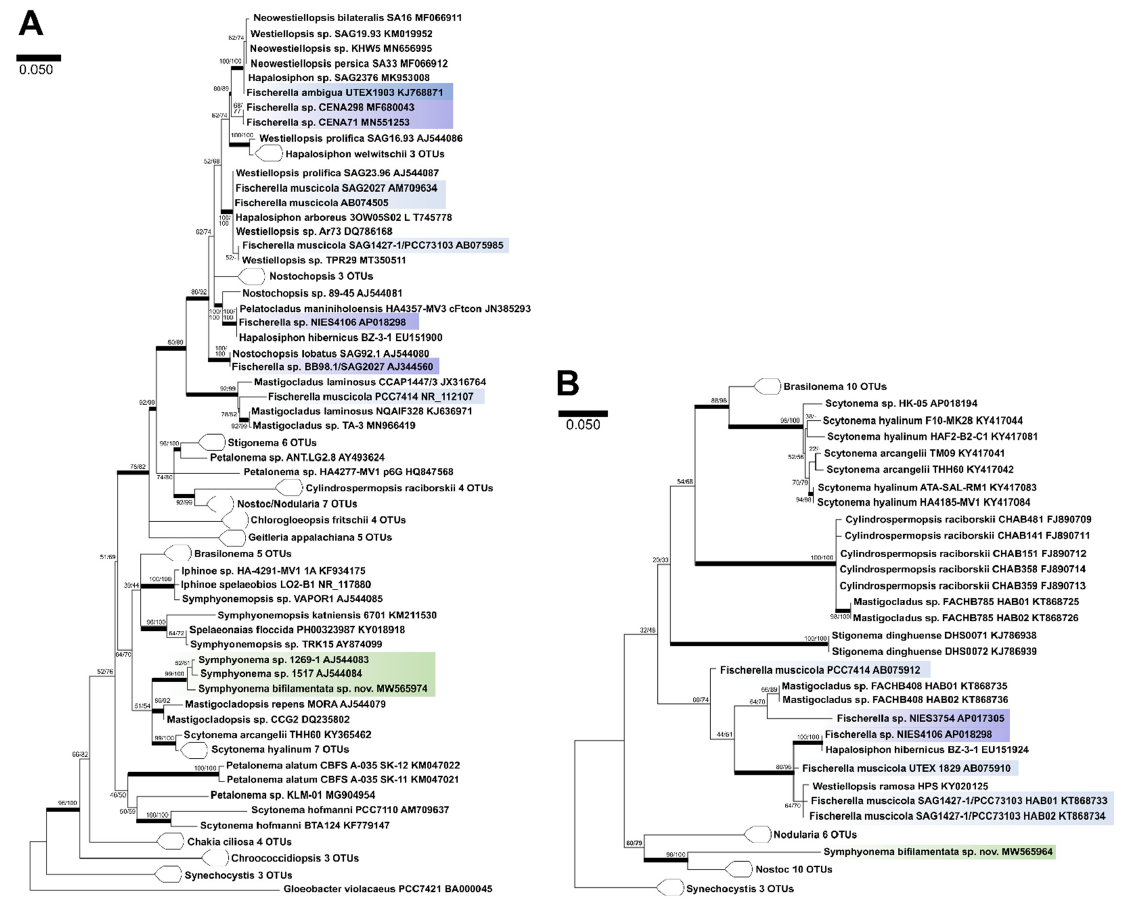
Figure 3. Comparative phylogenetic trees of 16S rRNA and protein coding gene region rbcLX . A Maximum likelihood (ML) tree obtained from 89 aligned 16S rRNA gene sequences with 1508 bp indicating the position of Symphyonema bifilamentata sp. nov. 97.28 rooted to Gloeobacter violacaeus PCC7421. B ML tree from 57 aligned sequences of the protein coding gene region rbcLX with 782 bp rooted to Synechocystis . Numbers on the nodes represent ML- and Bayesian bootstrap values respectively, (1000 replicates, each). Bold horizontal lines show lineages supported by at least 75 % of both bootstrap values. Bar represents 0.05 substitutions per nucleotide position. Symphyonema clade is highlighted in green, strains assigned to Fischerella ambigua in dark blue, strains assigned to F. muscicola are marked in light blue and Fischerella strains unassigned to species level are highlighted in purple.